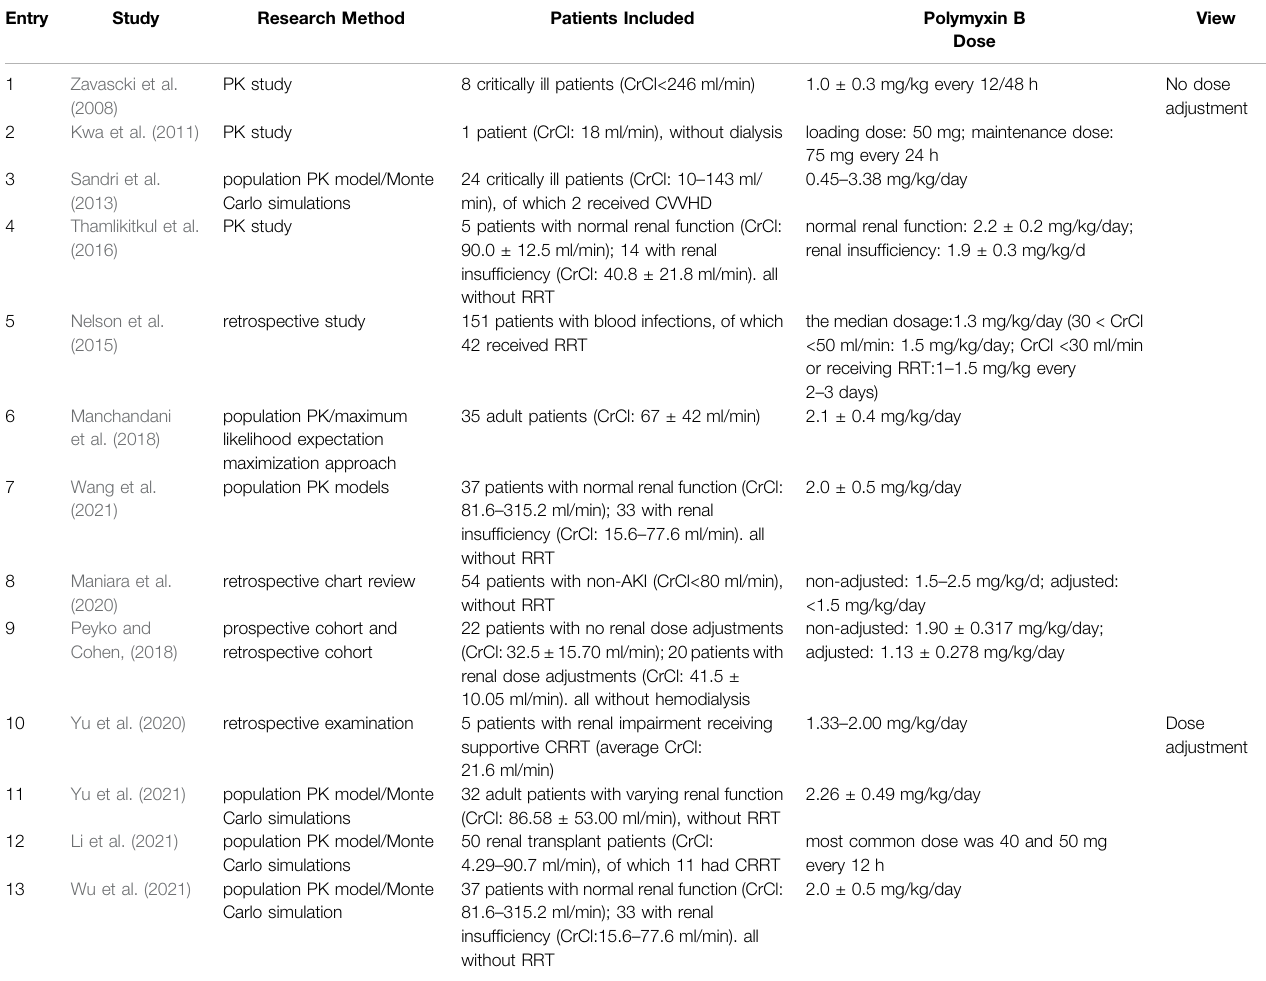
TABLE 1 | Summary of related